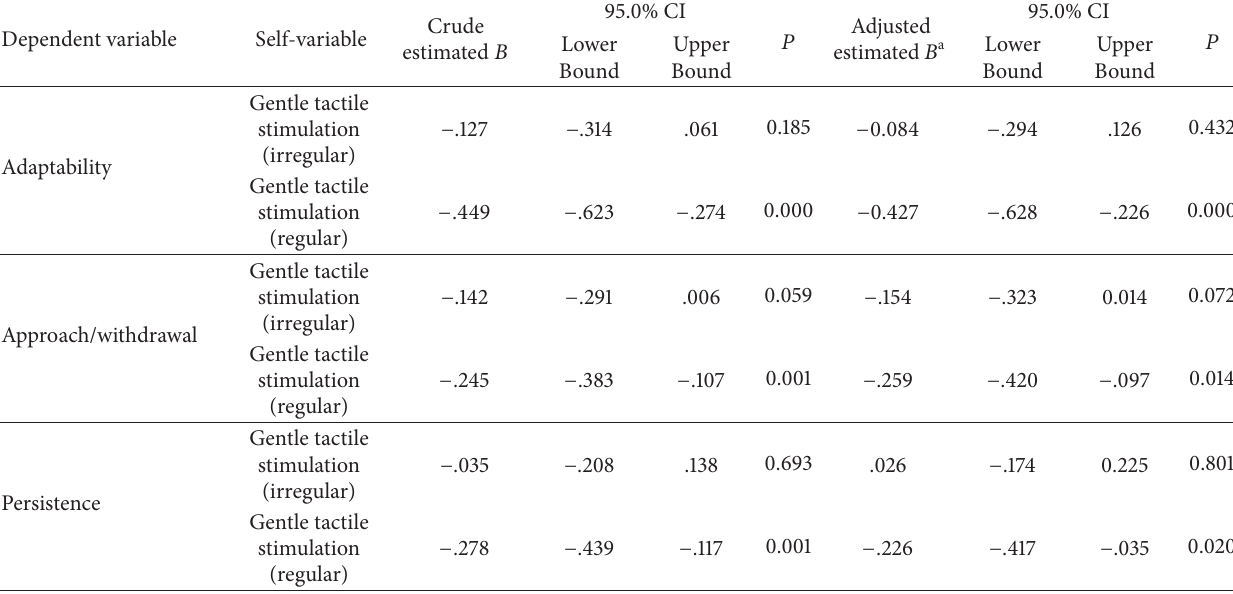
Table 6: Multivariable linear-regression analysis of the score of 3 dimensions of the babies on independent factors ( 𝑁 = 300 b ). Dependent